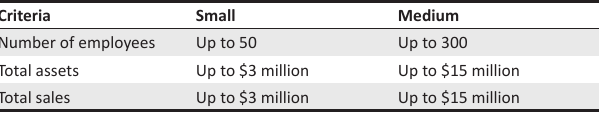
TABLE 7: World Bank’s definition of small enterprises.